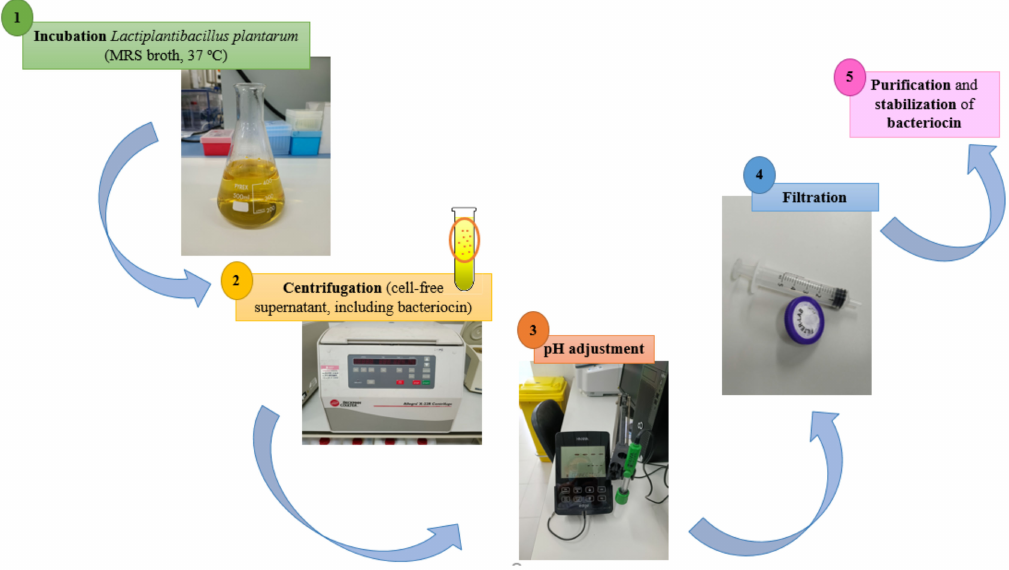
Figure 2. General scheme of bacteriocin production from Lactiplantibacillus